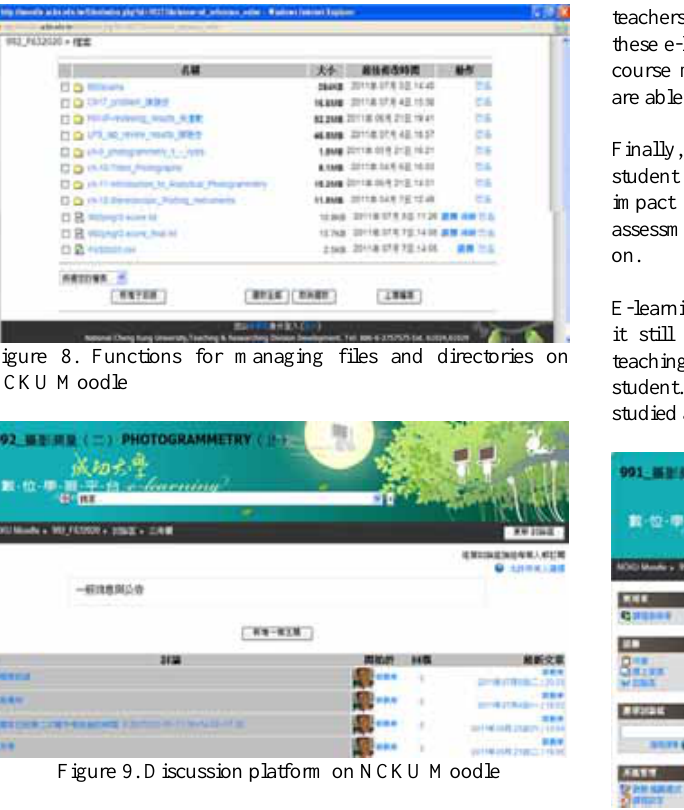
Figure 11. Multi-language functions of the NCKU